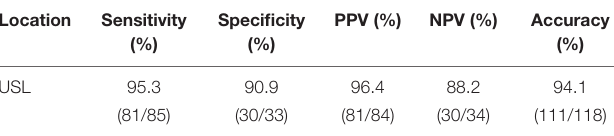
TABLE 3 | The value of TVS in diagnosis of USL involvement in deep endometriosis.